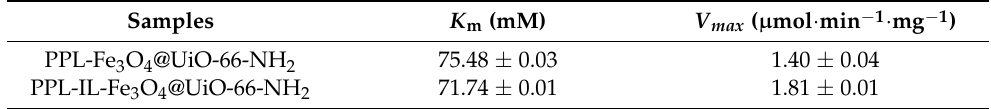
Table 2. Kinetic parameters of immobilized